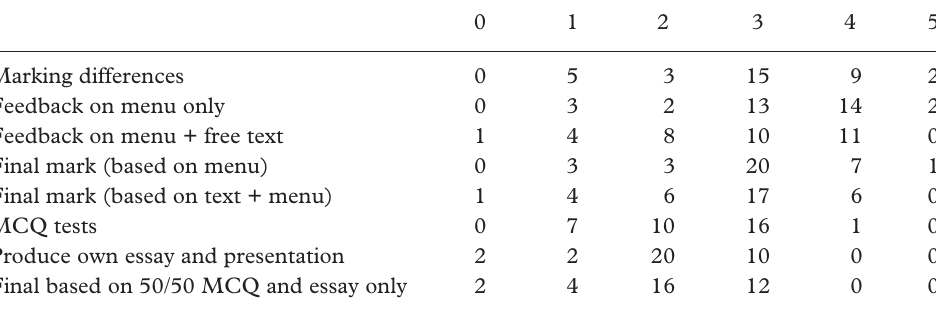
Table 7. Frequency distributions of